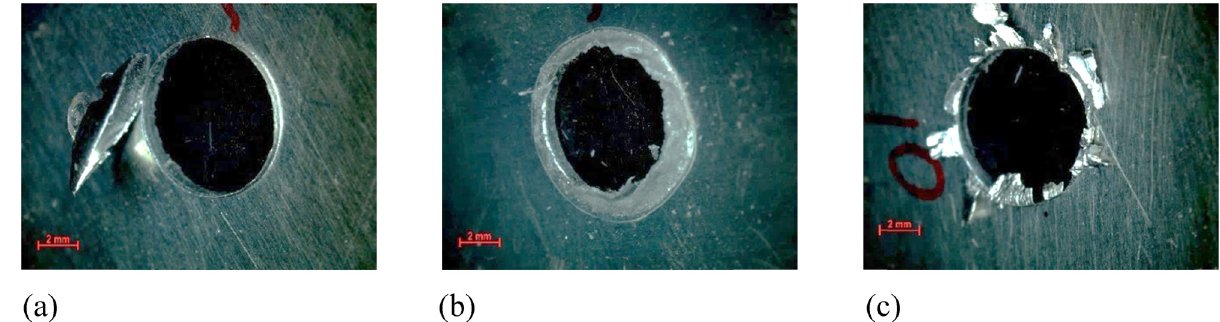
Figure 5: Burr types: ( a ) uniform ( with drill cap ) , ( b ) uniform, and ( c )